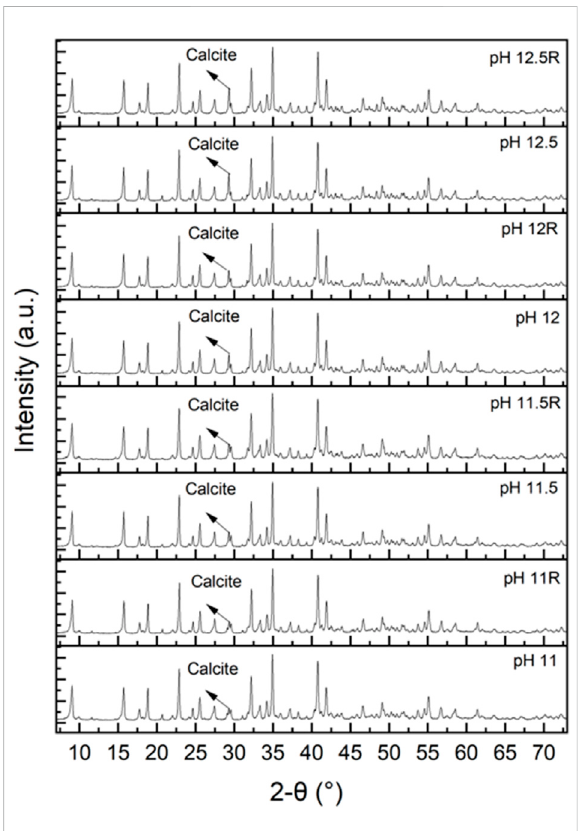
FIGURE 4 X-ray diffraction (XRD) patterns of precipitates from the ettringite precipitation experiments at pH range 11 – 12.5. R denotes repeated test. The unmarked peaks in the diffractograms are related to